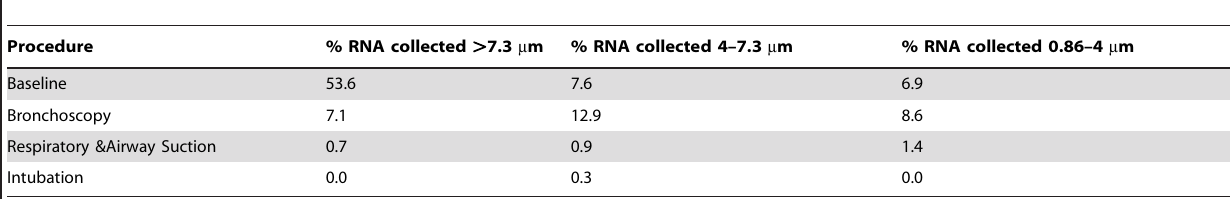
Table 2. The percentage of total RNA collected in each stage (size range) of the May impinger compared based on the WHO 2009 AGP